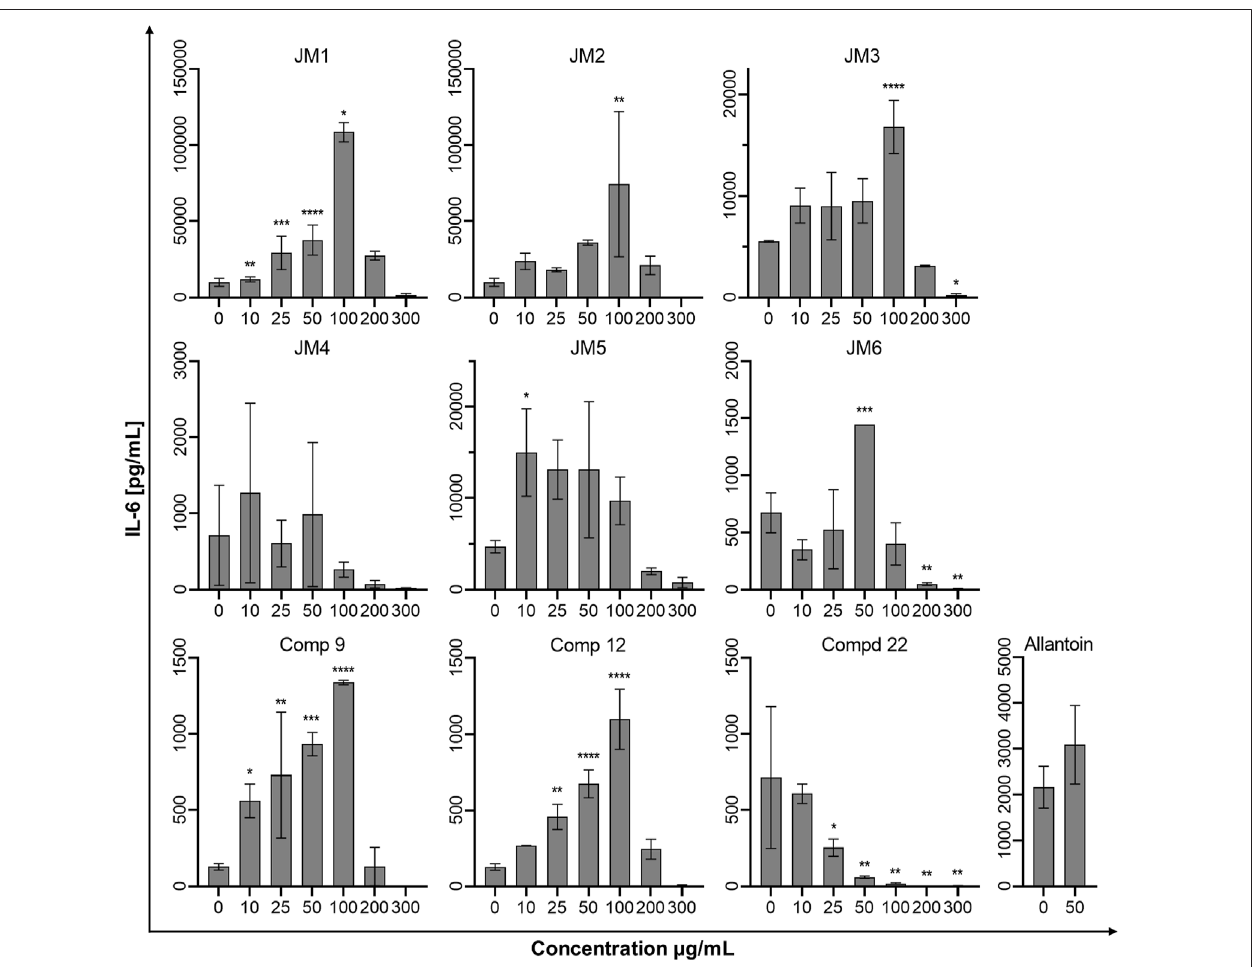
FIGURE4| Effectsofthe J.montana extracts JM1 – JM6 andtheirmaincomponents ( 9 , 12 ,and 22 )(10 – 300 μ g/mL)and allantoin(50 μ g/mL) onthereleaseofIL- 6.Meanvaluesfromthreeindependentexperiments( n =3)performedinduplicatearepresented.* p < 0.05versusthecontrolgroup,** p < 0.01versusthecontrolgroup, *** p < 0.001 versus the control group, **** p < 0.0001 versus the control group.